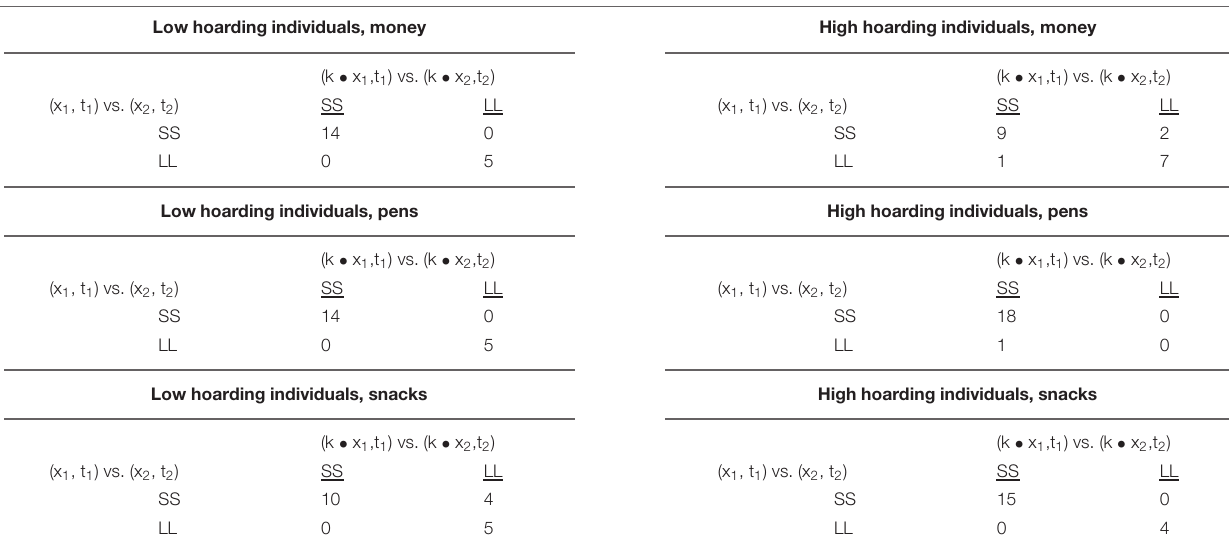
TABLE 4 | Cross-tabulations by group and domain for tests of the power utility function, with a constant added to both amounts with (x 1 , t 1 vs. x 2 , t 2 ) compared to (k (cid:129) x 1 , t 1 vs. k (cid:129) x 2 , t 2 ). Low hoarding individuals, money High hoarding individuals,